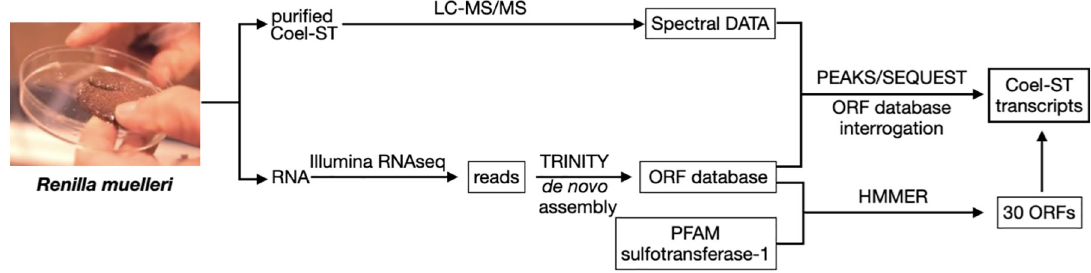
Fig 5. Outline of the hybrid approach followed for identification of the Coel-ST